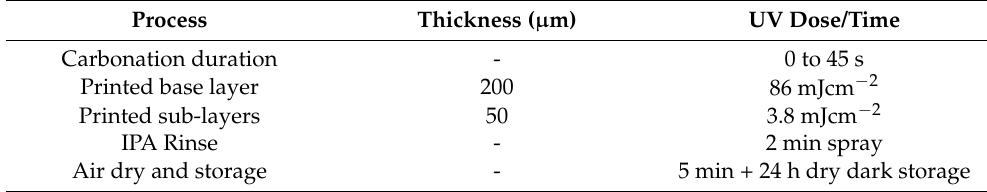
Table 1. Process parameters for test